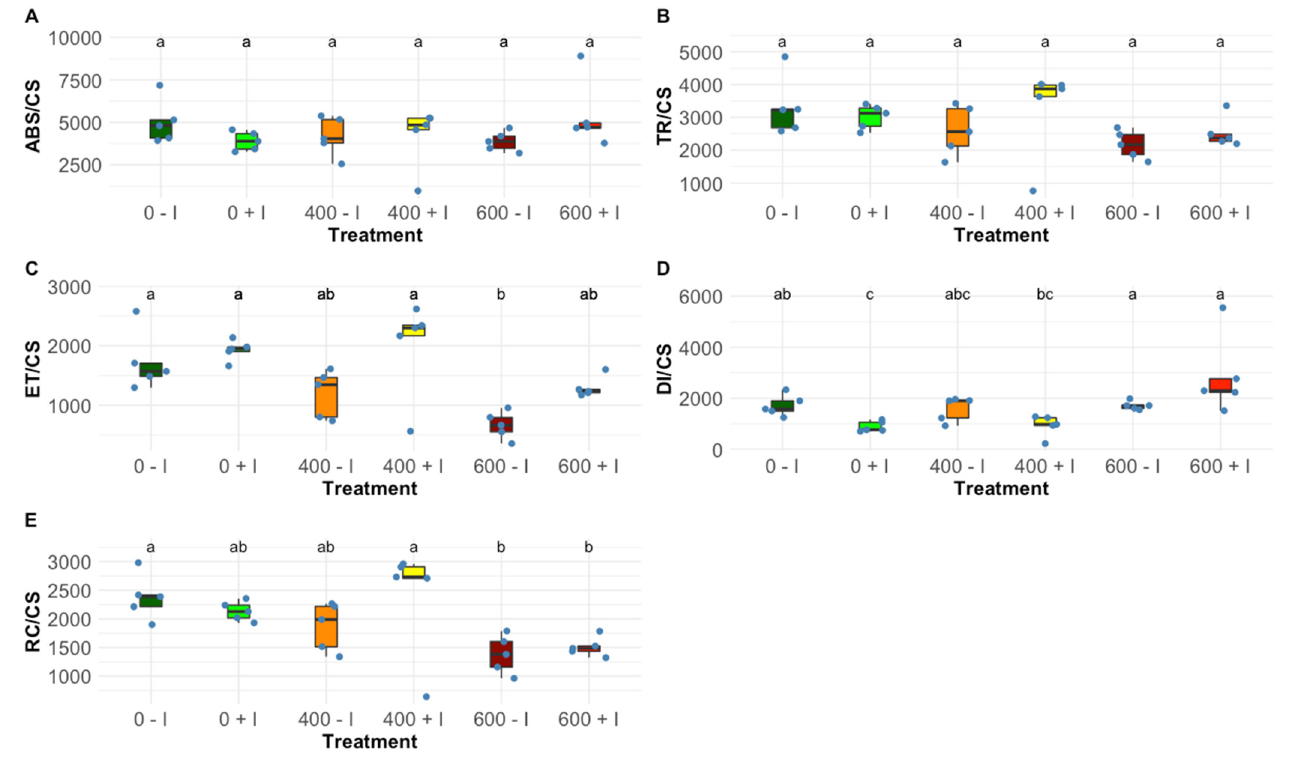
Figure 1. Phenomological energetic parameters, ( A ) absorbed energy flux (ABS/CS), ( B ) trapped energy flux (TR/CS), ( C ) electron transport energy flux (ET/CS), ( D ) dissipation energy flux (DI/CS) and ( E ) oxidized reaction centres (RC/CS) on a cross ‐ section basis, in non ‐ inoculated and inoculated Halimione portulacoides dark ‐ adapted leaves (N = 5), along with the tested NaCl concentrations. Letters indicate significant differences between treatments at p < 0.05.